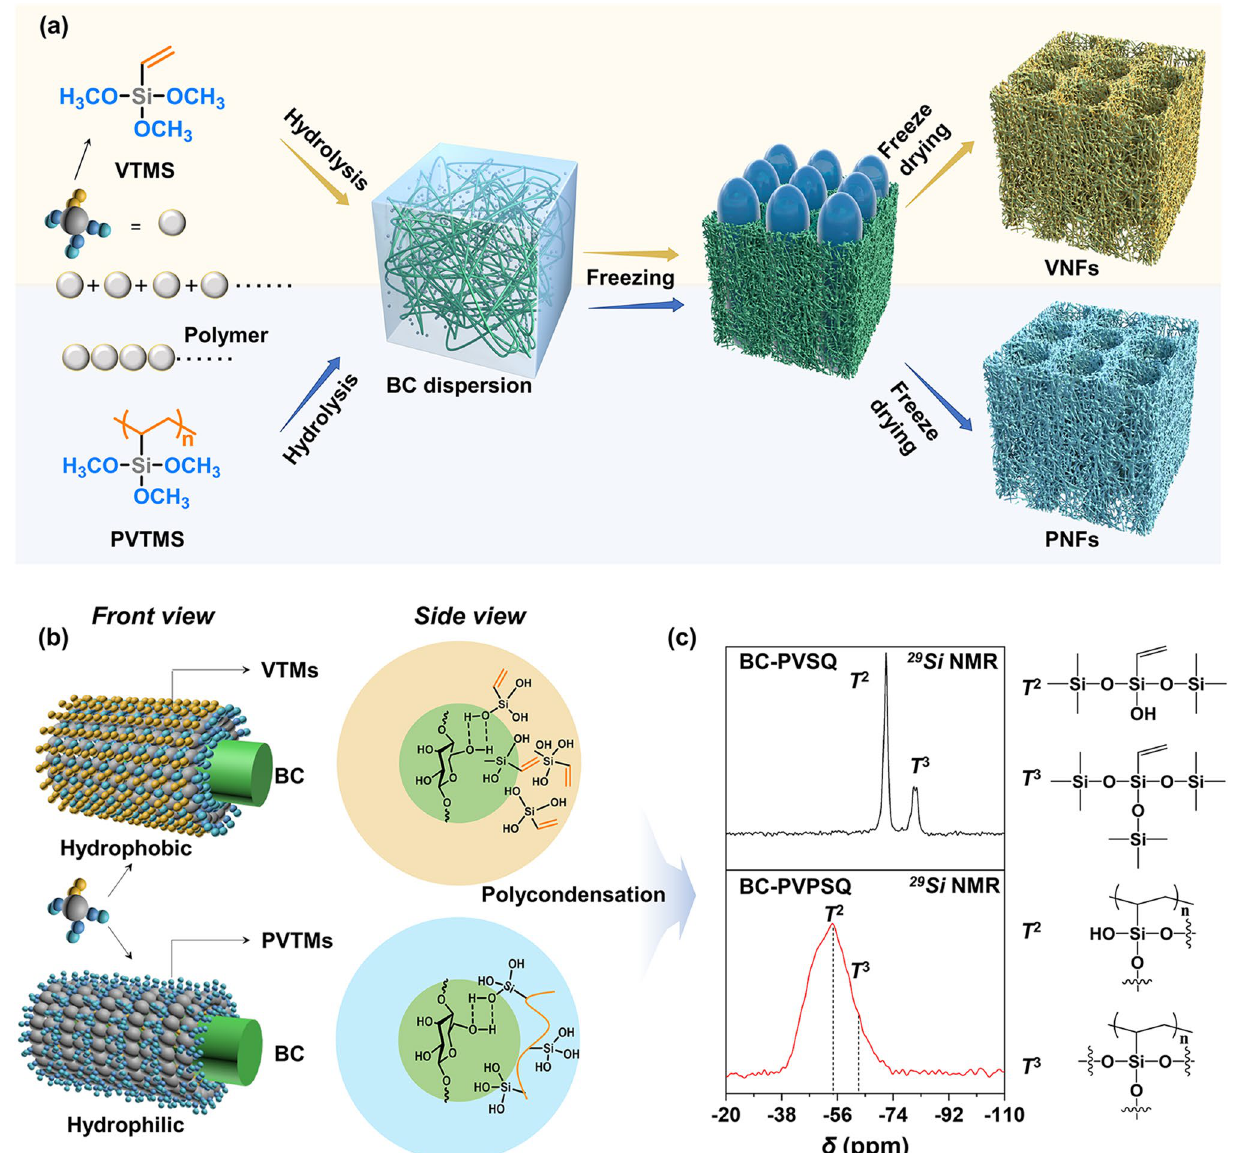
Fig. 1 Processing principles and synthesis of the hybrid aerogels with tunable wettability. a Roadmaps of preparation of superhydrophobic VNFs and superhydrophilic PNFs. VTMS can be directly used or polymerized as precursors. Then the monomer (VTMS) or polymer (PVTMS) precursors are respectively mixed with BC nanofibers in desired mass ratios. After freezing and freeze-drying processes, polyvinylsilsesquioxane (PVSQ) and polyvinylpolysilsesquioxane (PVPSQ) are yielded to coat on the framework of BC nanofibers, resulting in VNFs and PNFs, respec- tively. b Molecular orientations of siloxane on the surface of BC nanofibers. c 29 Si NMR spectra of PVSQ and PVPSQ, demonstrating the poly- condensation of VTMS and PVTMS that promoted by freeze-drying